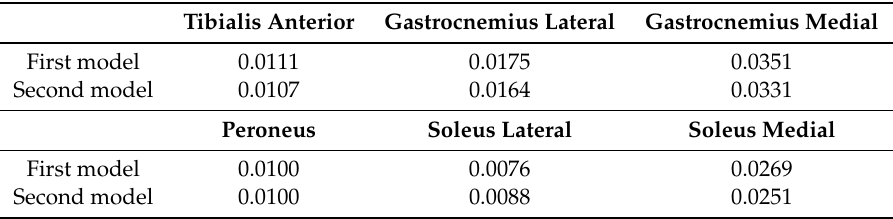
Table 5. Median root mean squared errors of the first half and the second half.